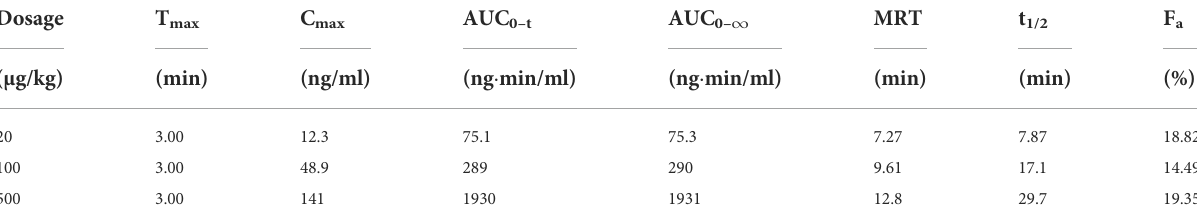
TABLE 2 Pharmacokinetic parameters of BPC157 in rats following intramuscular administrations of doses ranging between 5 and 120 μ g/kg (mean ± SD, n = 6). Dosage T max C max AUC 0 – t